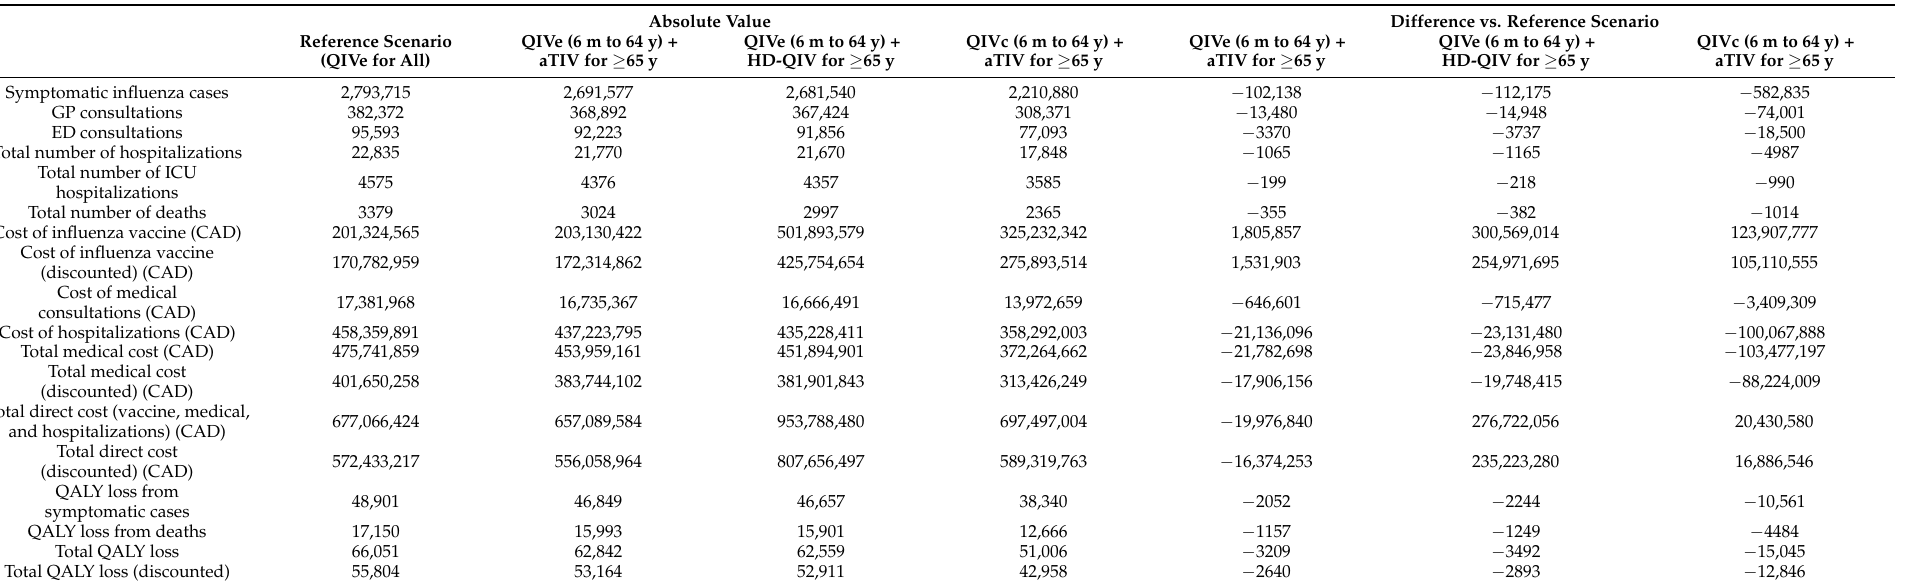
Table 3. Base case results and differences to the reference scenario (QIVe for all age